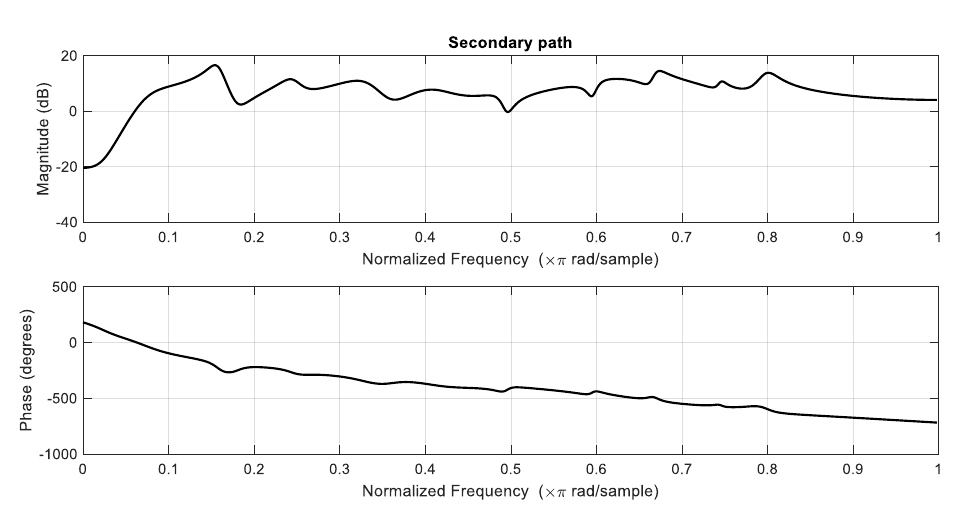
Figure 5. Secondary path.